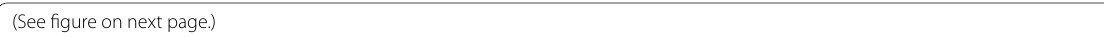
figure on next Fig. 1 a Distribution map of topography, fault, major historical earthquake and InSAR data in the Jiashi areas. The black beach balls are focal mechanism solutions of the historical earthquake from the GCMT catalog. The red star marks the epicenter of the Jiashi earthquake from CENC. The green box is the coverage of Sentinel SAR data. The blue dots represent the major cities. The black lines are faults that are from the display system of active faults in China provided by the Institute of Geology, China Earthquake Administration. (http://www.neote ctoni cs.cn/arcgi s/apps/ webap pview er/index .html?id 3c0d8 234c1 dc43e aa0be c3ea0 3bb00 bc). b Tectonic map of the Kalping thrust system. The red beach balls are focal = mechanism solutions of the Jiashi earthquake from USGS and GCMT. The purple circles represent the aftershocks till 17 June 2020 from CENC. The red arrows represent the horizontal velocity field relative to the Eurasian plate (from CMONOC between 1999 and 2019) provided by the GNSS Data, Products and Services Platform (http://www.cgps.ac.cn/) of the China Earthquake